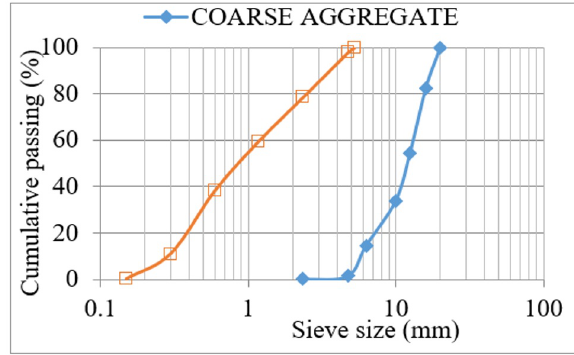
Fig. 1. Particle size distribution of coarse and fine aggregates